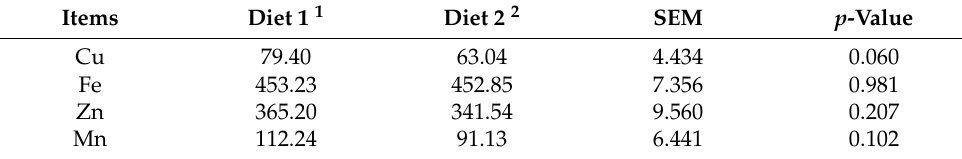
Table 2. Essential microelements concentration in two kinds of diets (dry matter,